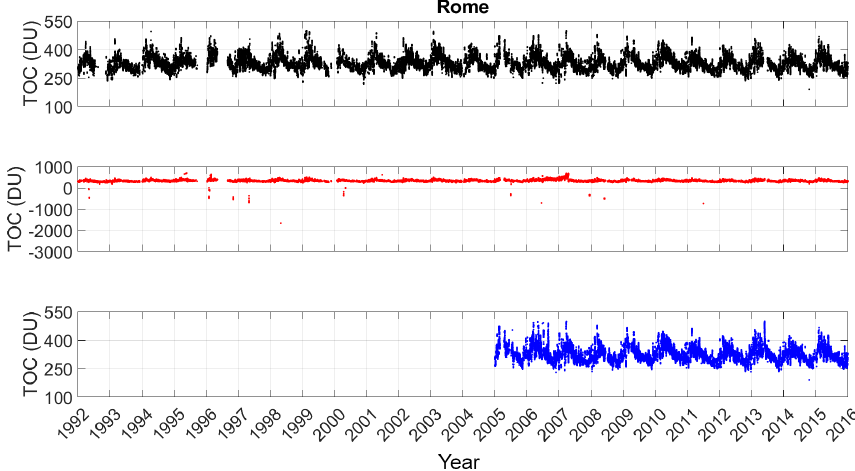
Figure 2. Individual TOC values generated by BPS (black), O3Brewer (red) and EUBREWNET (blue) at Rome.